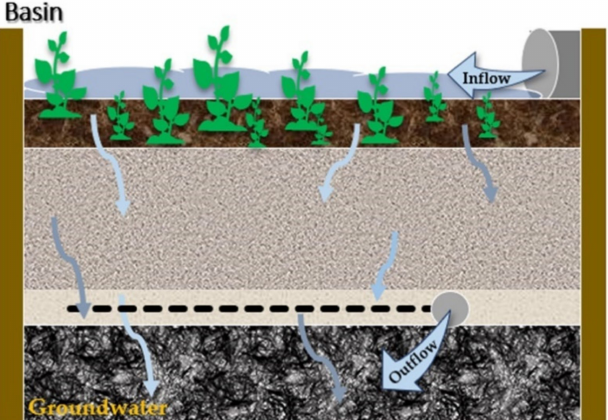
Figure 1. Lorton Road bioretention research site and positioning: ( a ) Map of the analyzed bioretention location (created with ArcGIS). ( b ) Aerial image of bioretention with piped/culvert flow represented by blue arrows, surface flow represented by solid white arrows, and perforated underdrain repre- sented by dotted lines (images by authors).